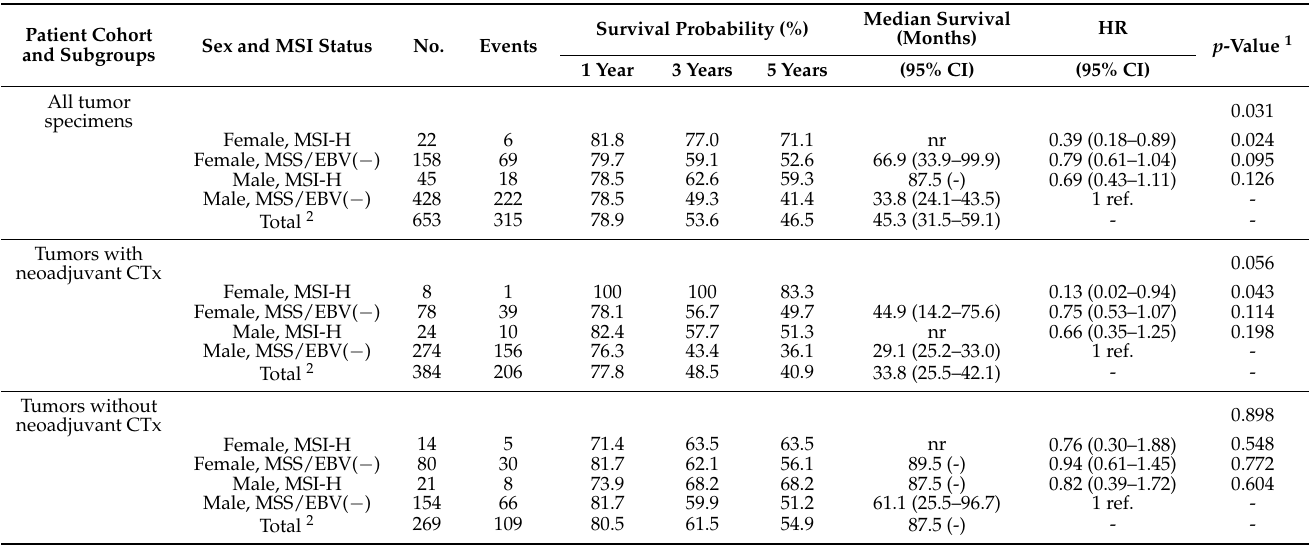
Table 3. Survival data of the patient cohort and subgroups stratified according to sex of the patients in association with the MSI